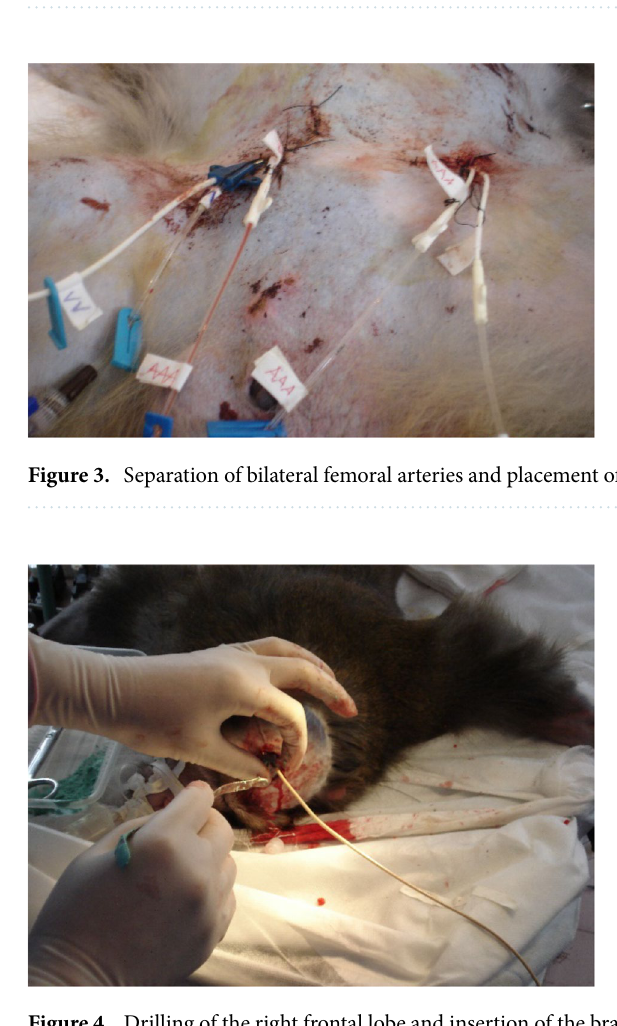
Figure 2. Separation of bilateral jugular arteries and placement of tubes.